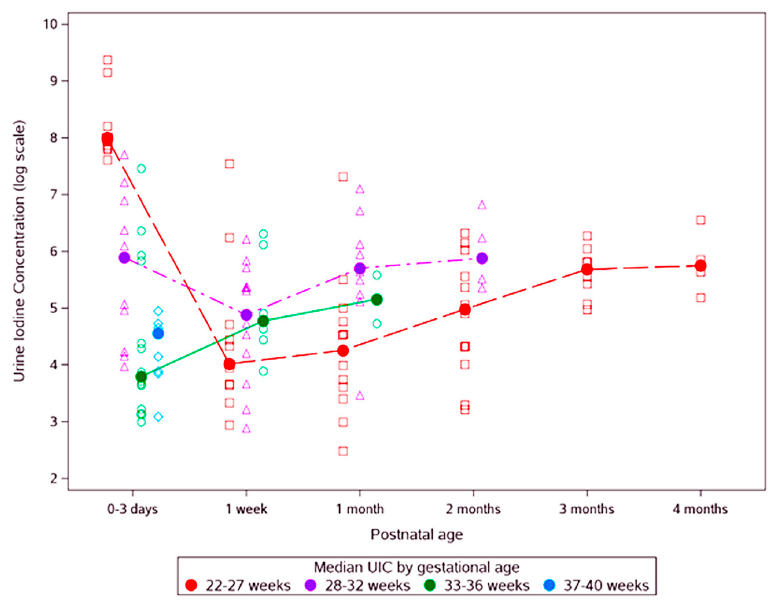
Figure 2. Changes in neonatal urinary Iodine levels (log scale) over time in various gestational age groups.